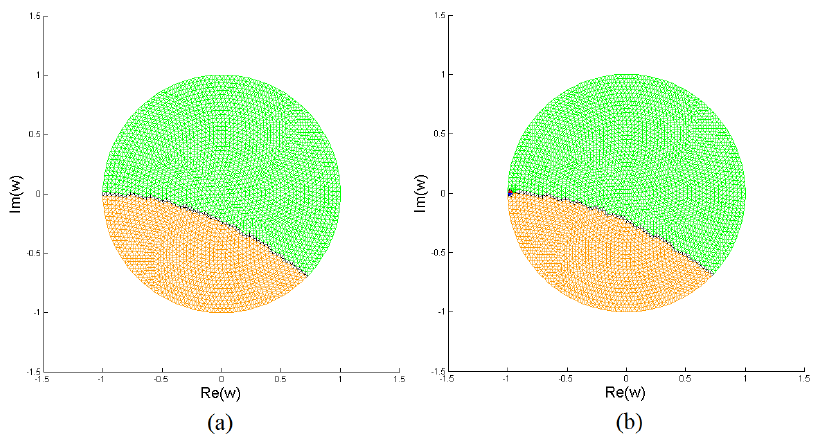
Figure 8. Distribution of nodes with Delaunay’s triangulation for the stability test of a fractional-order digital filter with the use of GRPF for mesh size ( a ) r = 0.04 and ( b ) r = 0.039. A single zero is not detected for mesh size r = 0.04 because it is not dense enough. Phase quadrants of mesh nodes